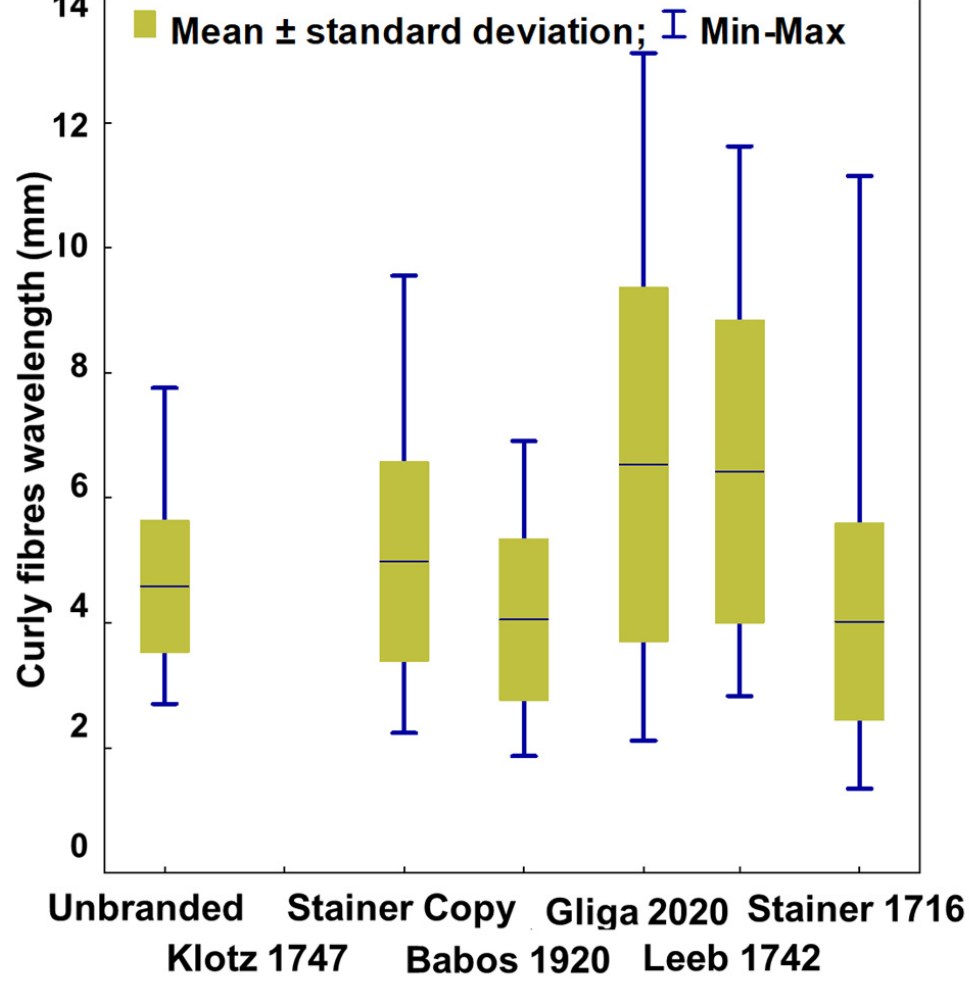
Figure 8. The variation of the curly fibers’ wavelength from maple back plates of analyzed violins.